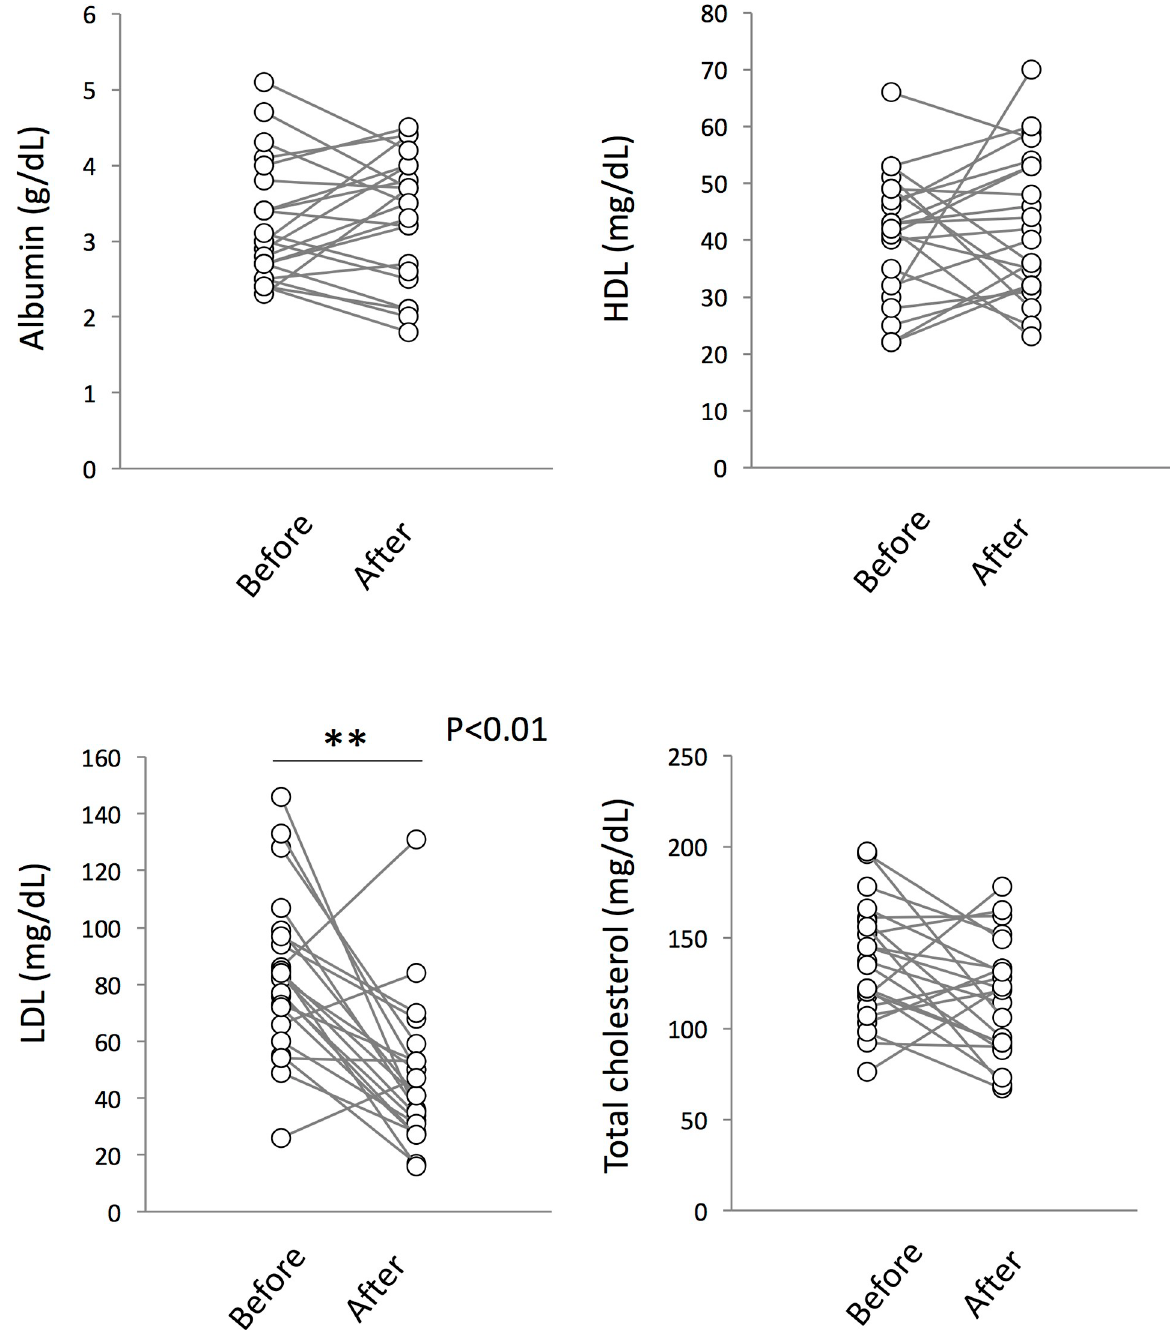
Fig 6. Changes in serum nutritional status in ATB patients during treatment. Analysis of serum nutritional levels showed a significant decrease in serum LDL levels in ATB patients after treatment. �� : p <